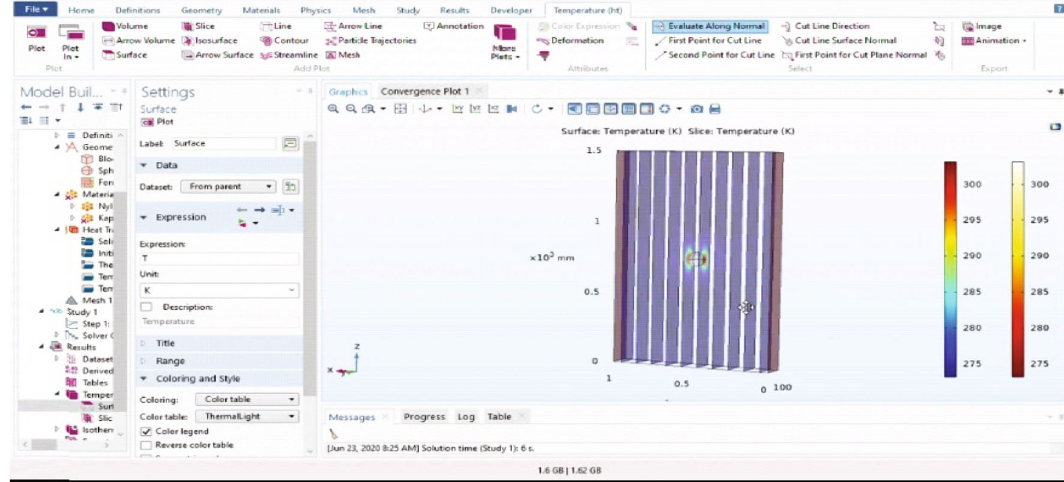
Figure 4: Heat transfer from Kapton to nylon.